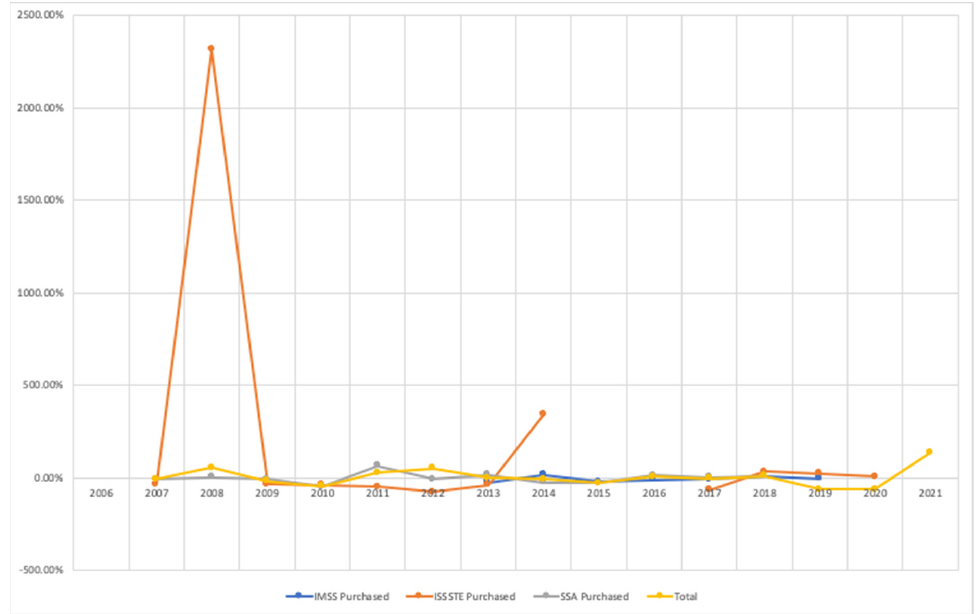
Figure 2. BCG vaccines. Percent variation of annual acquisition.